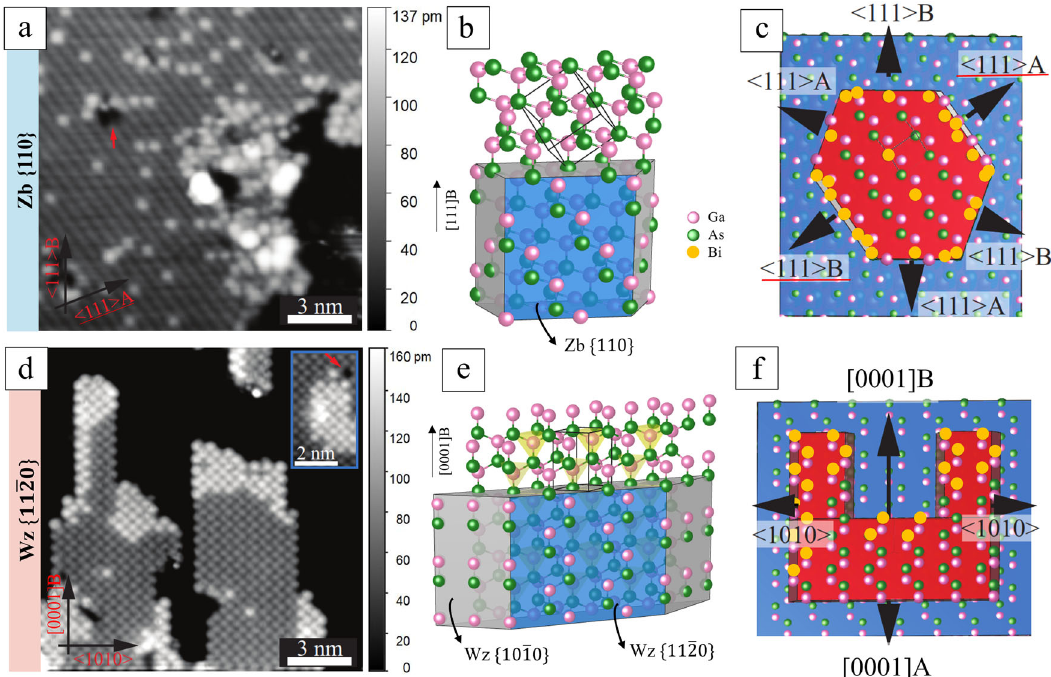
(cid:1) (cid:3) -type surface, Fig. 2 Bi incorporates into the surface layer of GaAs NWs. a , d shows STM images of the Zb {110}-type surface and of the 11 (cid:1) 20 respectively, including surface steps along different directions between the top terrace and a one monolayer lower terrace. The lower terraces appear black here due to contrast enhancement, the height scale bars are shown on the right side. Different contrast settings of the same STM image can be found for comparison in Supplementary Fig. 6. The many small bright protrusions correspond to Bi atoms. Red arrows in ( a ) and ( d ) point at atomic vacancies. The inset in ( d ) indicates a 2D GaBi island near a vacancy in the middle of a fl at terrace. b , e illustrate the GaAs 3D crystal structure for ( b ) Zb and ( e ) Wz phase, overlaid with the NW shape. c , f show 2D models corresponding to the surfaces seen in ( a ) and ( d ). The red and blue areas represent the top terrace and the second atomic layer, respectively, of the NW surface, separated by surface steps. An arbitrary shape is chosen for the top terrace, but the possible directions of the surface steps are determined by the crystal structure and correspond to those visible in ( a ) and ( d ). Incorporation of Bi atoms (yellow dots) is illustrated, occurring at vacancies and via atomic step edges facing 〈 111 〉 A/B directions on the Zb{110}-type surface ( c ) and step (cid:1) (cid:3) edges facing the [0001] B growth direction on the Wz 11 (cid:1) 20 -type surface ( f ), as motivated by the positions of the Bi atoms observed in ( a ) and ( d ). The direction indexes with red underline in ( a ) and ( c ) present the projections of <111 > -type directions in {110} plane. In ( b ), ( c ), ( e ), and ( f ), pink (green/yellow) spheres depict Ga (As/Bi) atoms. V T = − 4.4 V, I T = 100 pA for all STM